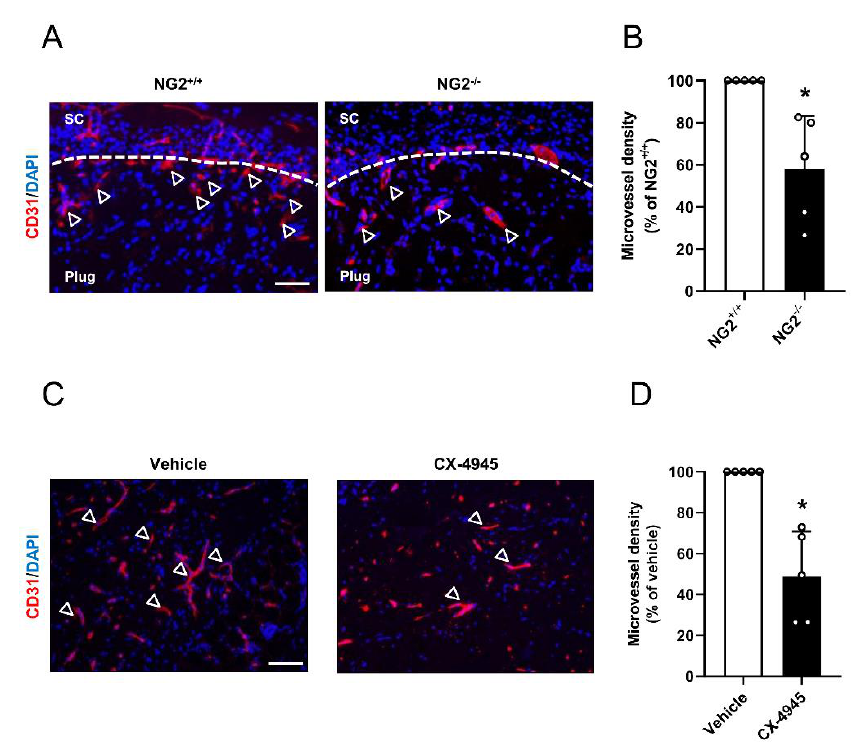
Figure 6. ( A ) Immunohistochemical detection of murine CD31-positive cells in empty Matrigel plugs of NG2 +/+ and NG2 − / − mice after 7 d. Arrows show CD31-positive blood vessels; dotted lines represent edge of the plugs; SC = subcutaneous tissue. Scale bar: 150 µ m. ( B ) Quantitative analysis of the microvessel density of Matrigel plugs after 7 d. Matrigel plugs of NG2 +/+ mice were set as 100%. Mean ± SD. * p < 0.05 versus NG2 +/+ ( n = 5). ( C ) Immunohistochemical detection of human CD31 positive-cells in Matrigel plugs containing HUVEC mixed with vehicle- or CX-4945-treated pericytes in a ratio 10:1 after 7 d. Arrows show CD31-positive blood vessels. Scale bar: 150 µ m. ( D ) Quantitative analysis of the microvessel density of Matrigel plugs after 7 d. Matrigel plugs containing vehicle-treated pericytes were set 100%. Mean ± SD. * p < 0.05 versus vehicle ( n = 5).